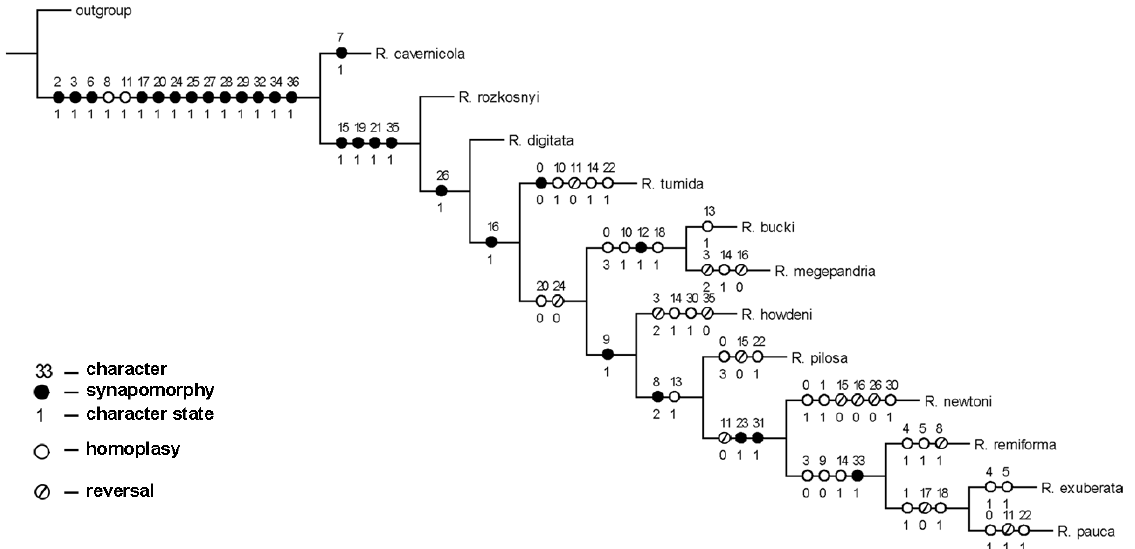
Fig. 7. Phylogeny of species of Rudolfina Roháček, 1987. Characters and character states refer to those given in Table 1. Tree selected from among 27 equal length trees. Length = 72, Ci = 56, Ri